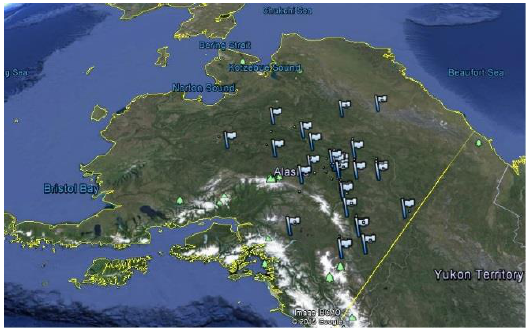
Figure 2. Metrological stations in Alaska